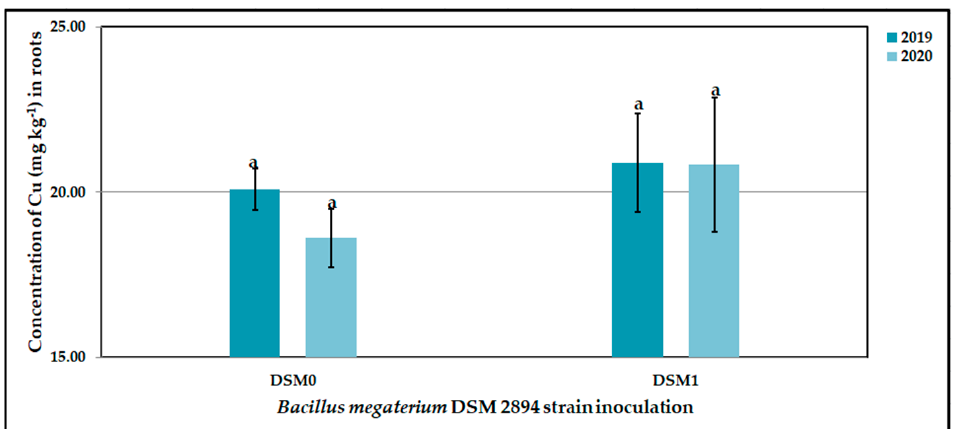
Figure 16. Influence of Bacillus megaterium DSM 2894 var. on root copper (Cu, mg kg − 1 ) contents of CaCO 3 -stressed sweet potato plants in 2019 and 2020 seasons. Bars with a different letter indicate significant difference between treatments at p ≤ 0.05. DSM 0 = non-inoculated with Bacillus megaterium DSM 2894 var., DSM 1 = inoculated with Bacillus megaterium DSM 2894 var.